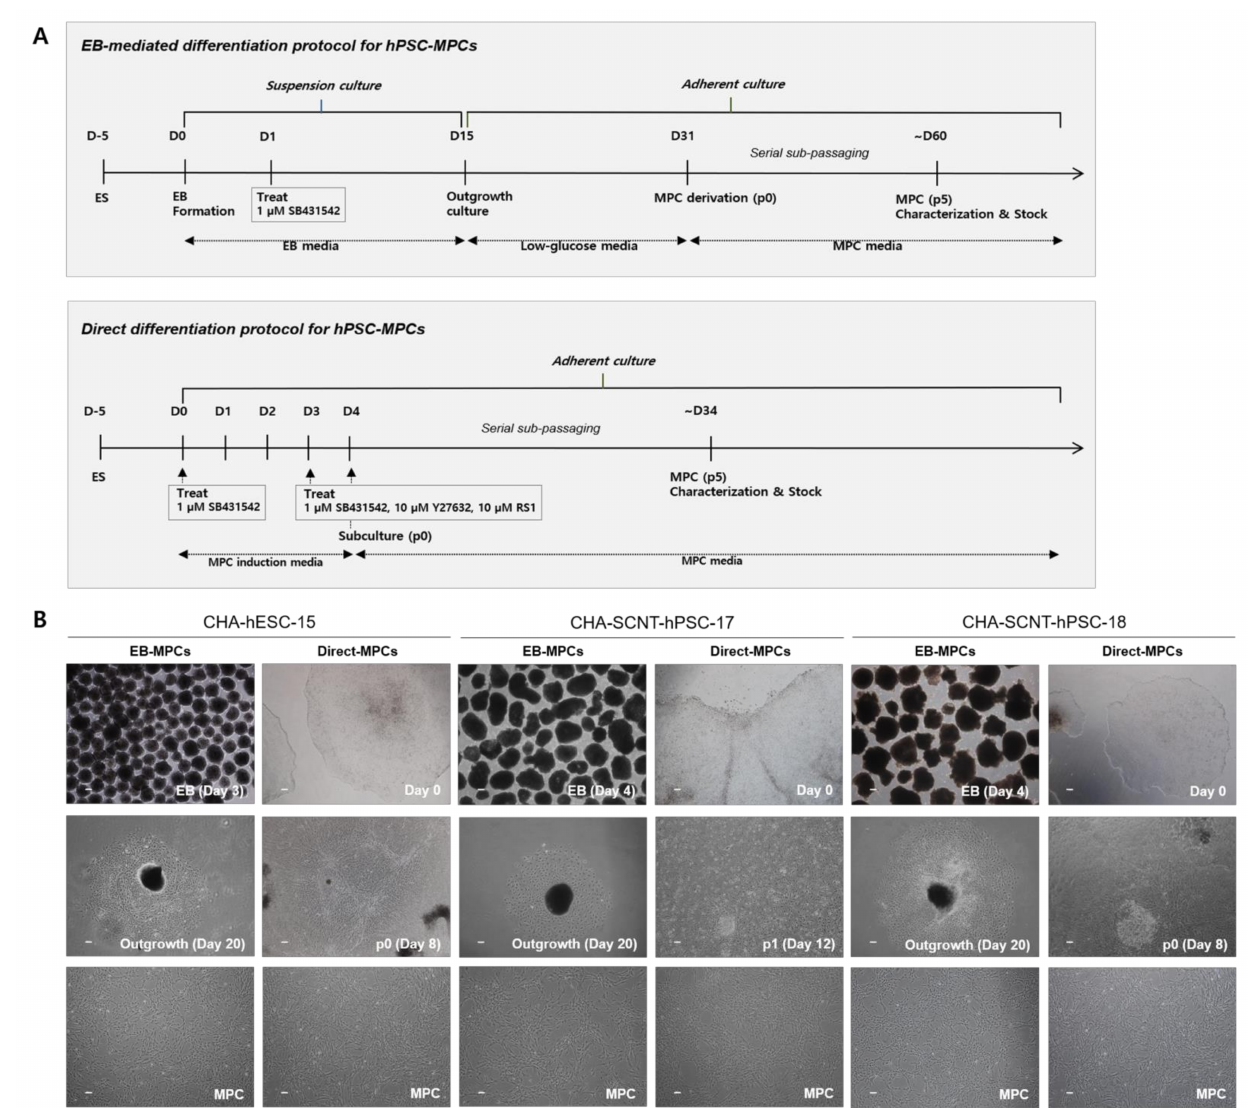
Figure 1. Differentiation procedure and representative morphologies of human pluripotent stem cells differentiated into mesenchymal progenitor cells (hPSC-MPCs). ( A ) Schematic diagram of the differentiation procedures used to generate EB/Direct-MPCs derived from hPSCs. ( B ) Representative phase contrast microscopic images of hPSC-EB-MPCs and hPSC-Direct-MPCs. Bars, 100 µ M (magnification, 40 ×